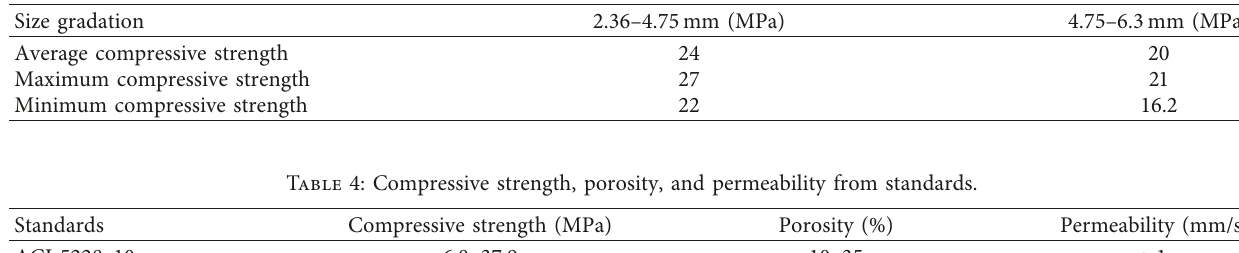
Table 3: Compressive strength of the pervious concrete mixes.